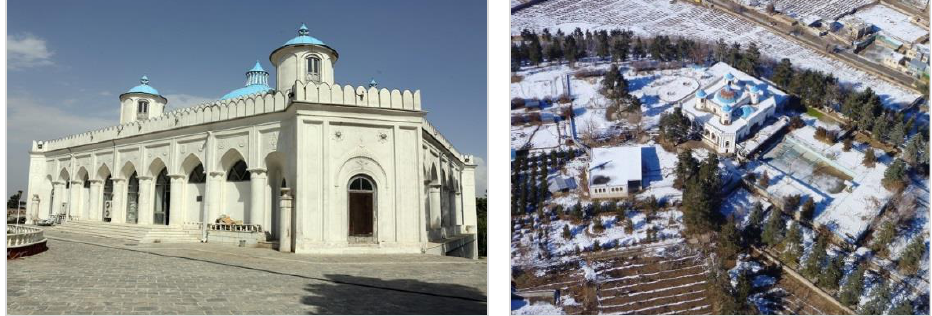
Figure 10 Bagh e Bala Palace and surrounded natural views (Mudl,